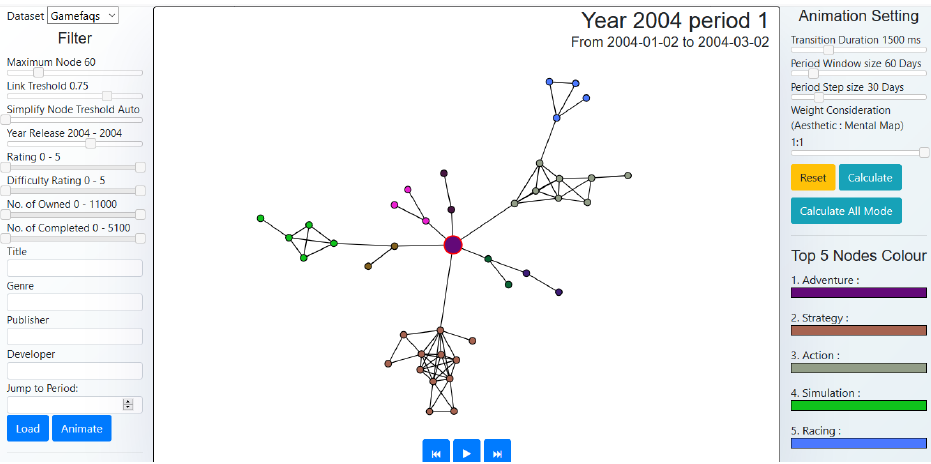
Figure 4. Front-end interface.